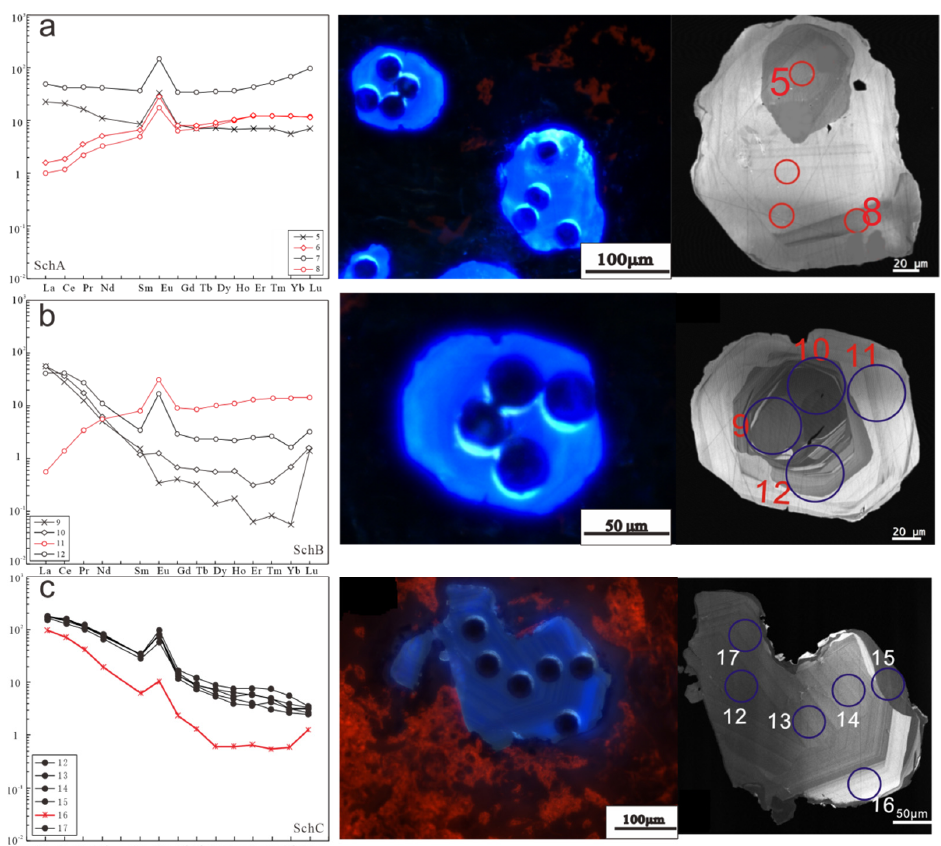
Figure 11. The characteristics of red curves, which are “uncoordinated” among SchA ( a ), SchB ( b ), SchC ( c ): diagrams on the left are REE distribution patterns of scheelite, the middle photos are cold cathodoluminescence images and the photos on the right are corresponding SEM-CL images of the grains. The normalization values were taken from Taylor and McLennan (1985) [33].